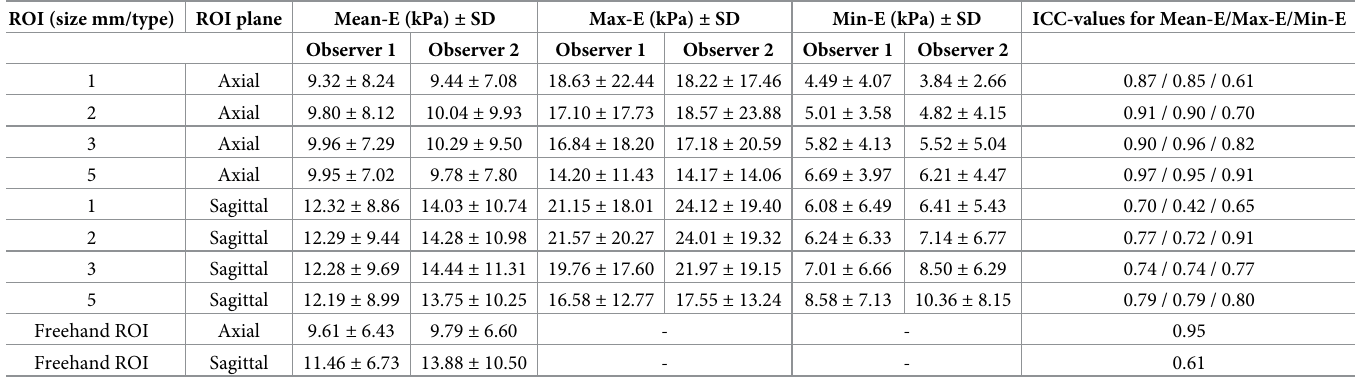
Table 3. Intraclass correlation coefficient (ICC) for different regions of interest (ROIs).